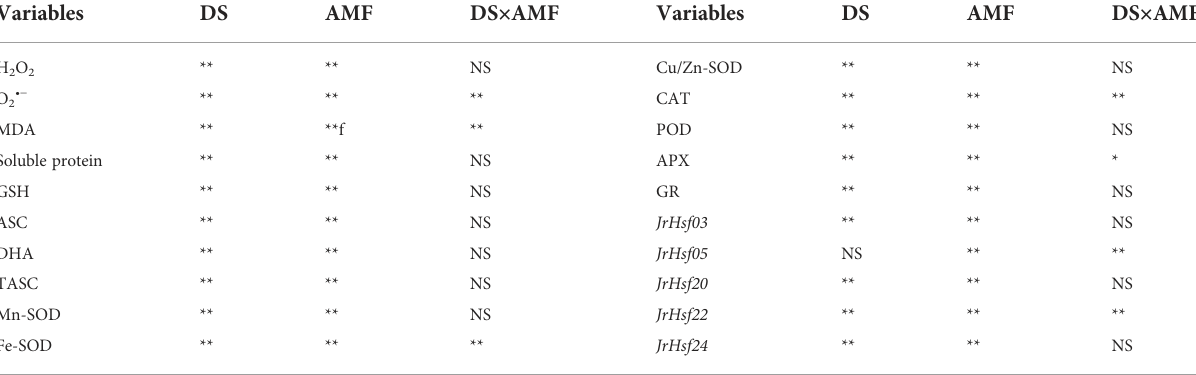
TABLE 3 Signi fi cance of variables between AMF and non-AMF colonized walnut seedlings grown in well-watered (WW) and drought stress (DS).